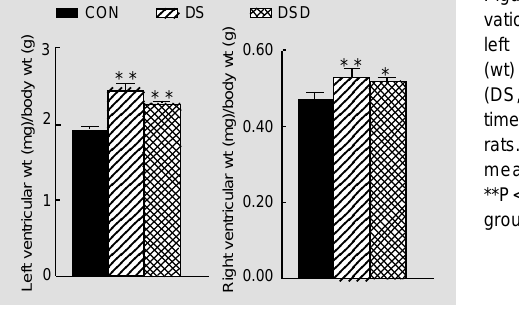
Figure 1 - Effect of renal dener- vation (DSD, N = 9) on ratios of left and right ventricular weight (wt) of deoxycorticosterone-salt (DS, N = 11) hypertensive and time-match control (CON, N = 9) rats. Values are reported as the mean ± SEM. *P<0.05 and **P<0.01 compared to control group values.